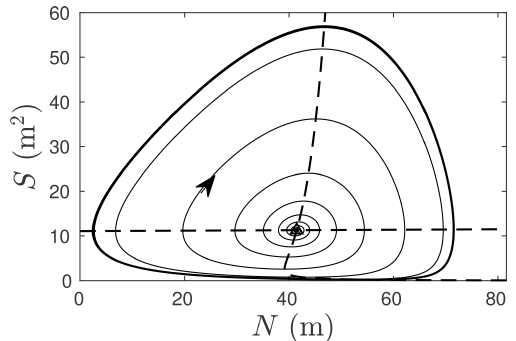
Figure 4. The periodic solution of Fig. 3 plotted in a phase plane. The thin curve represents a solution that approaches the limit cycle shown by the thick curve as indicated by the arrow. The instability of the steady-state solution (where the nullclines cross) is clearly visible, since evolution along the thin line is away from that steady